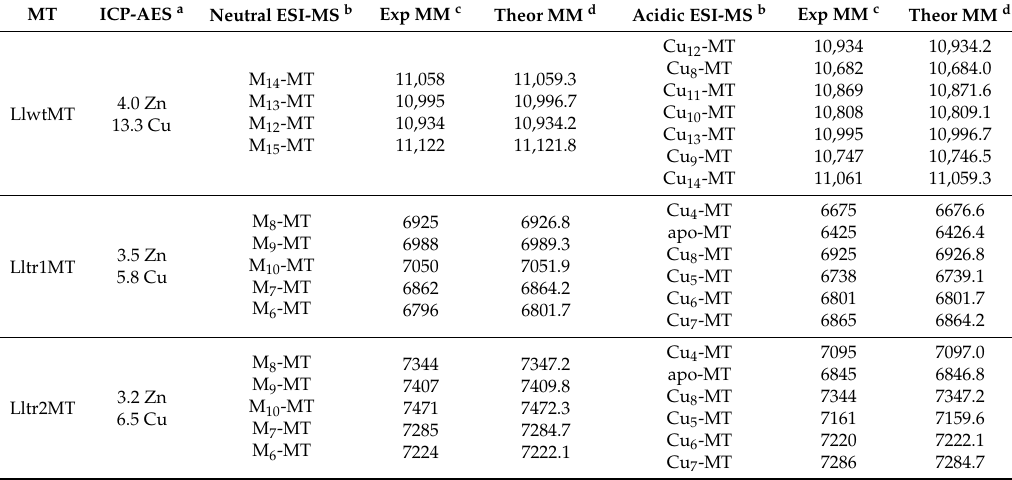
Table 2. Analytical characterization of the recombinant Cu-complexes of LlwtMT, Lltr1MT, and Lltr2MT, obtained from cultures grown with normal aeration (no complexes could be recovered from low aeration